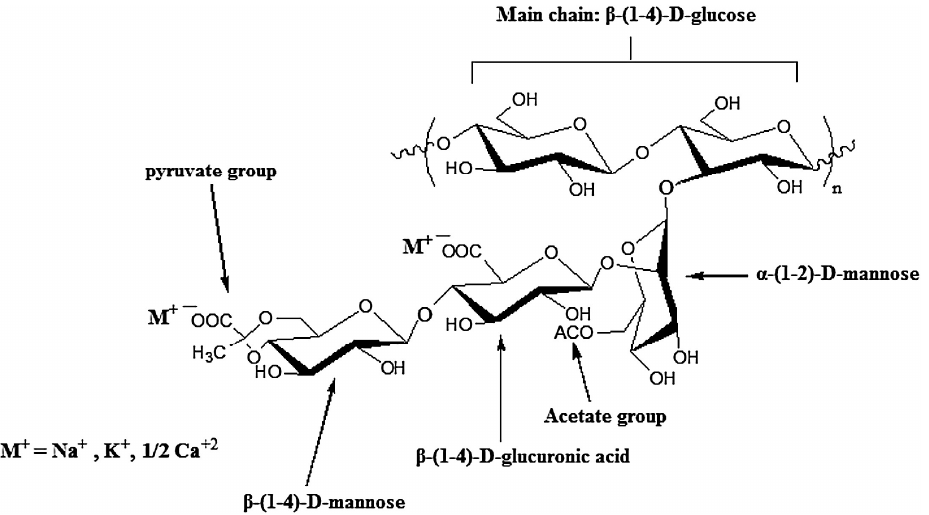
Figure 11. Penta-saccharide repeating unit in XG structure. Reproduced from [117] with permis-